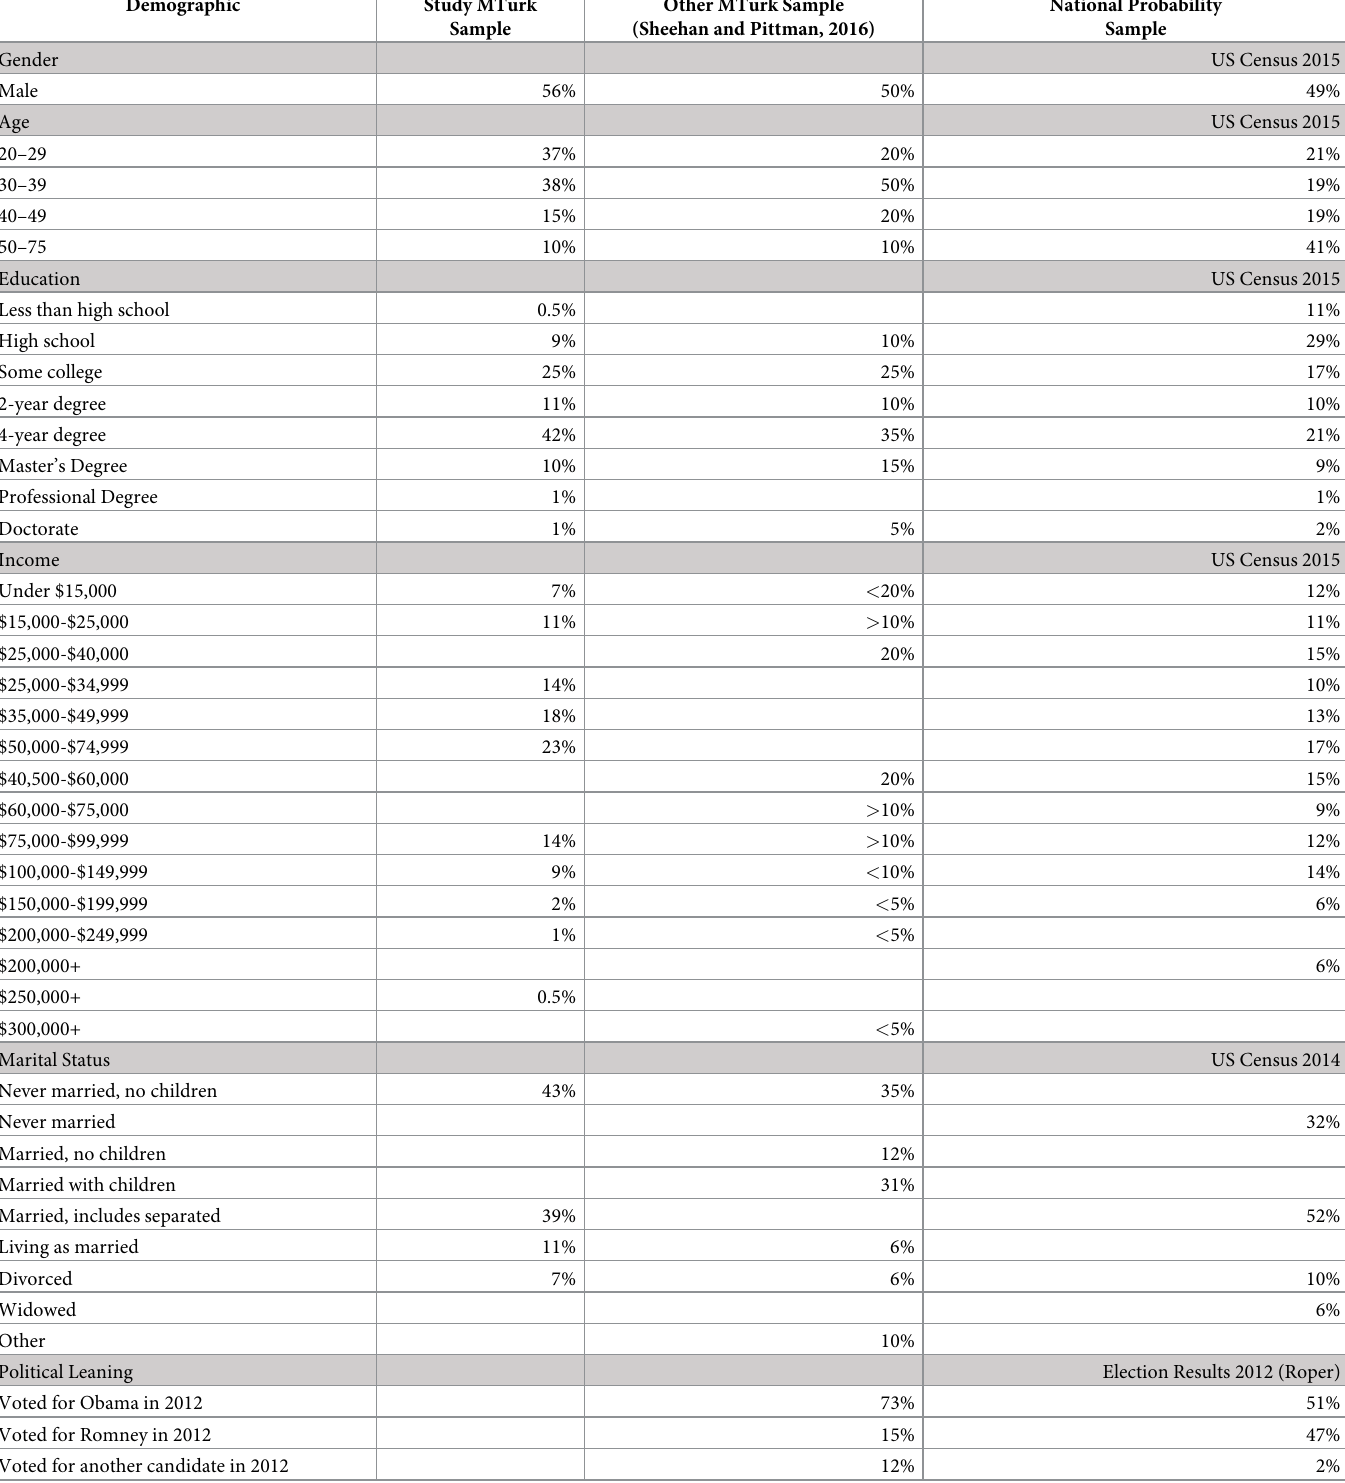
Table 5. Respondent information relative to MTurk and national